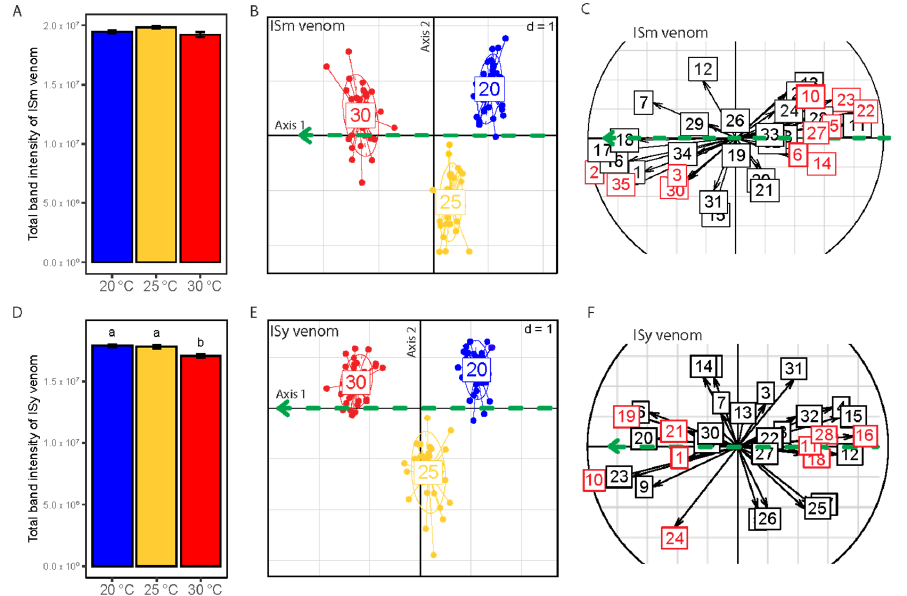
Figure 5. Impact of temperature on venom during parasitoid nymphal development. ( A , D ) Total intensity of venom bands (proxy of the amount of protein in venom) in ISm ( A ) or ISy ( D ). Different letters indicate a significant difference between temperatures. Bars indicate standard errors. ( B , E ) Position of L. boulardi ISm ( B ) or ISy ( E ) individuals on the two discriminant axes. Individuals are grouped and colored according to the rearing temperature (20 °C, 25 °C and 30 °C). The green ar- rows represent the trend of the venom change with increasing temperature (i.e., linear regressions calculated from the coordinates of the three centroid points corresponding to the three tempera- tures). ( C , F ) Correlation circles indicating the correlation of protein bands with linear regressions in ISm ( C ) or ISy ( F ). The green arrows are the same as in ( B , E ). The numbers correspond to the protein bands. Bands in red are significantly correlated with linear regressions, meaning that their intensity varies with temperature. See Supplementary Tables S8–S11 for statistical outputs.